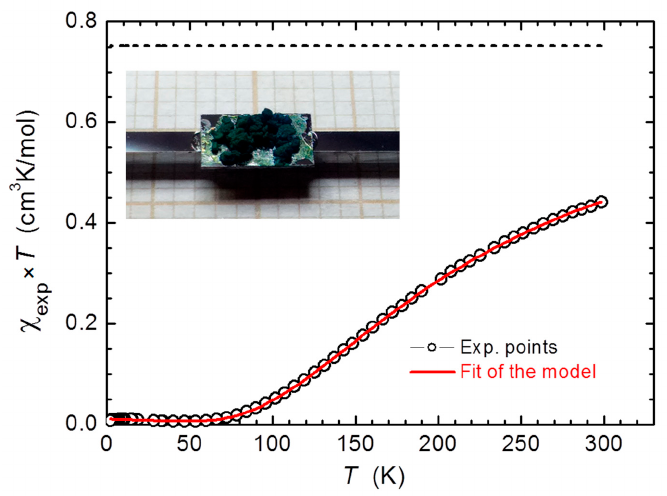
Figure 8. Experimental magnetic susceptibility χ exp × T of [Cu 2 (tig) 4 (tigH) 2 ] plot vs. temperature T . Experimental points are marked by black circles and the results of the modelling including T-dependent response of a Cu(II)–Cu(II) dimer (mid-to-high T range), a Curie paramagnetic-like contribution (very low temperatures) and T-independent diamagnetism of the host are depicted as the red solid line. The black dashed line denotes the Curie constant calculated for two noninteracting S = ½ spins. The inset: [Cu 2 (tig) 4 (tigH) 2 ] powder specimen attached to the rectangular Si support plate and mounted onto a Si holder.